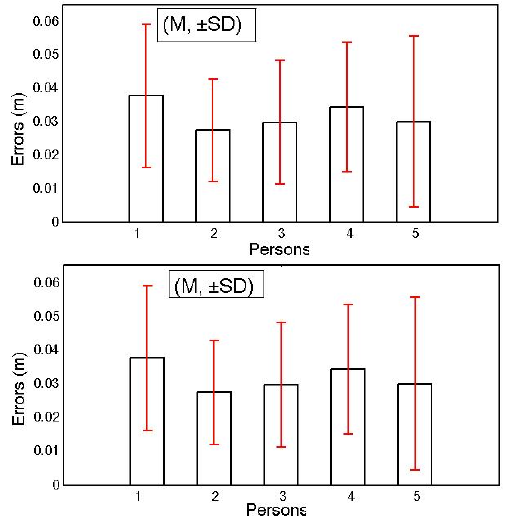
Figure 17. CoP error between the posturography platform measures and the trajectories provided by Arboris replaying CodaMotion data on X (top) and on Y (bottom) for all the